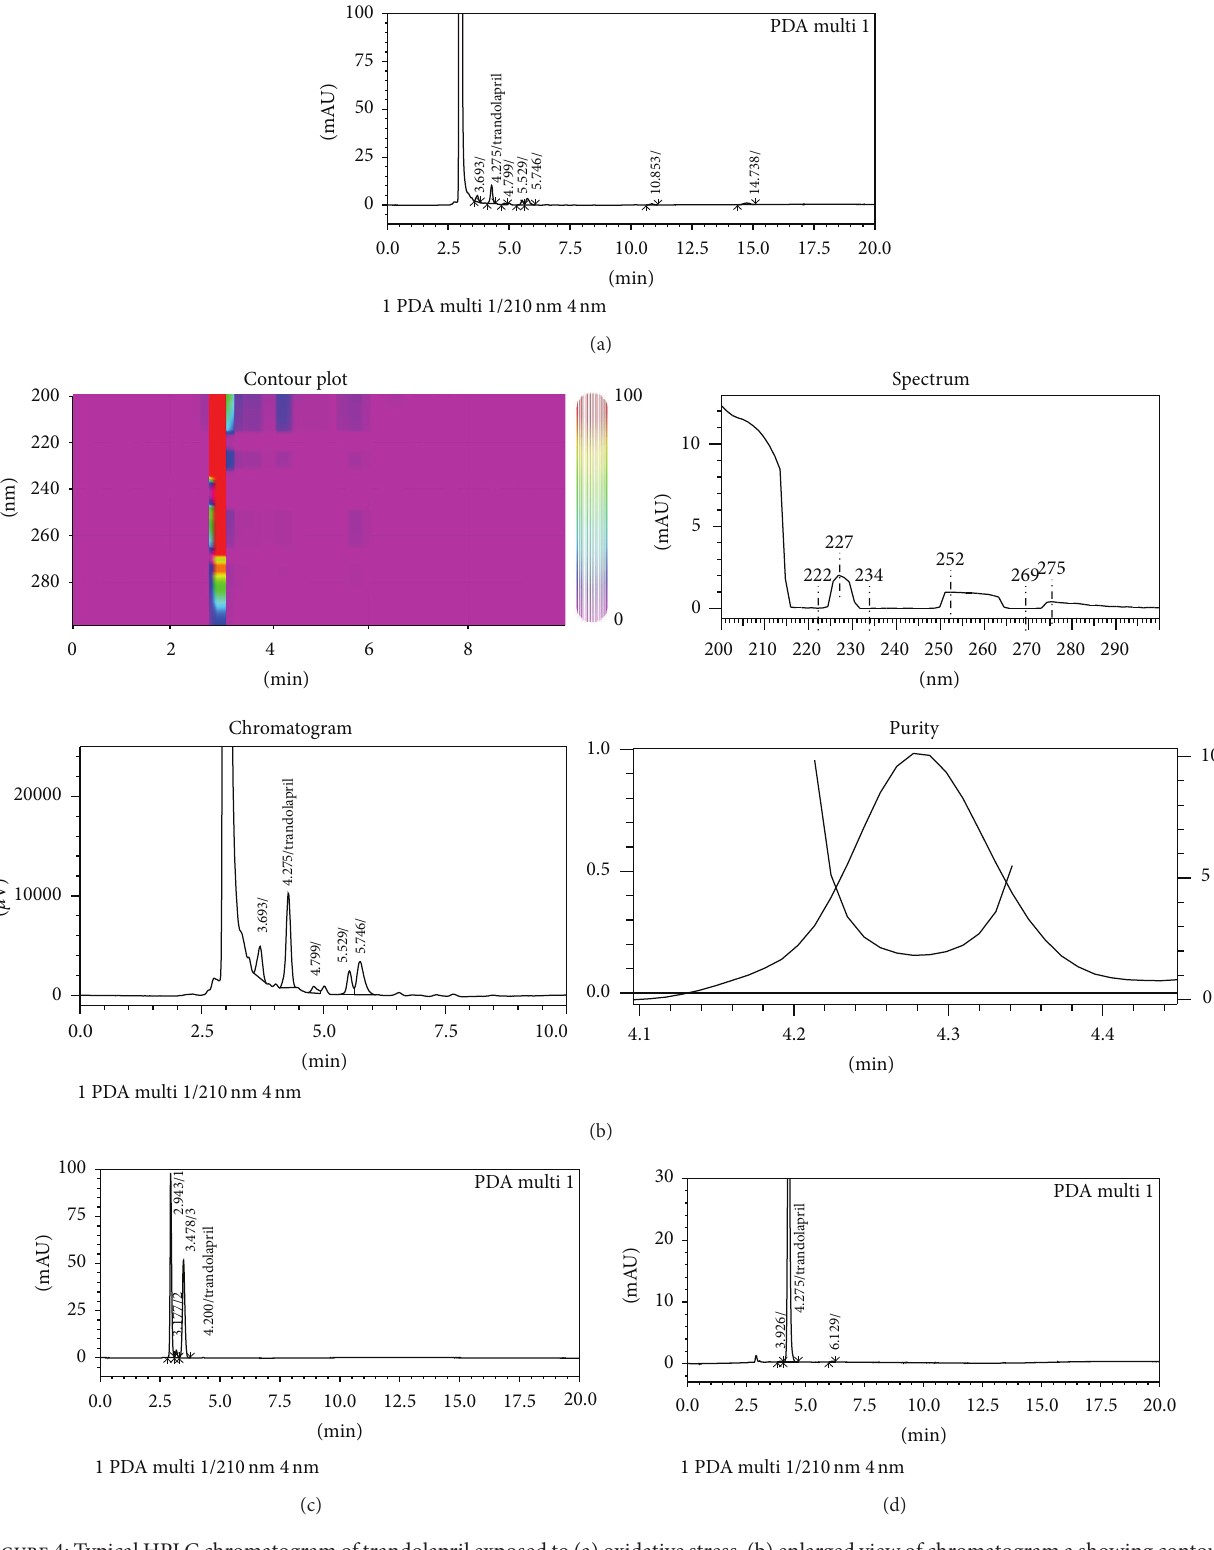
Figure 4: Typical HPLC chromatogram of trandolapril exposed to (a) oxidative stress, (b) enlarged view of chromatogram a showing contour plot, chromatogram, UV spectra, and peak purity, (c) alkaline stress, and (d) acidic stress condition showing degraded